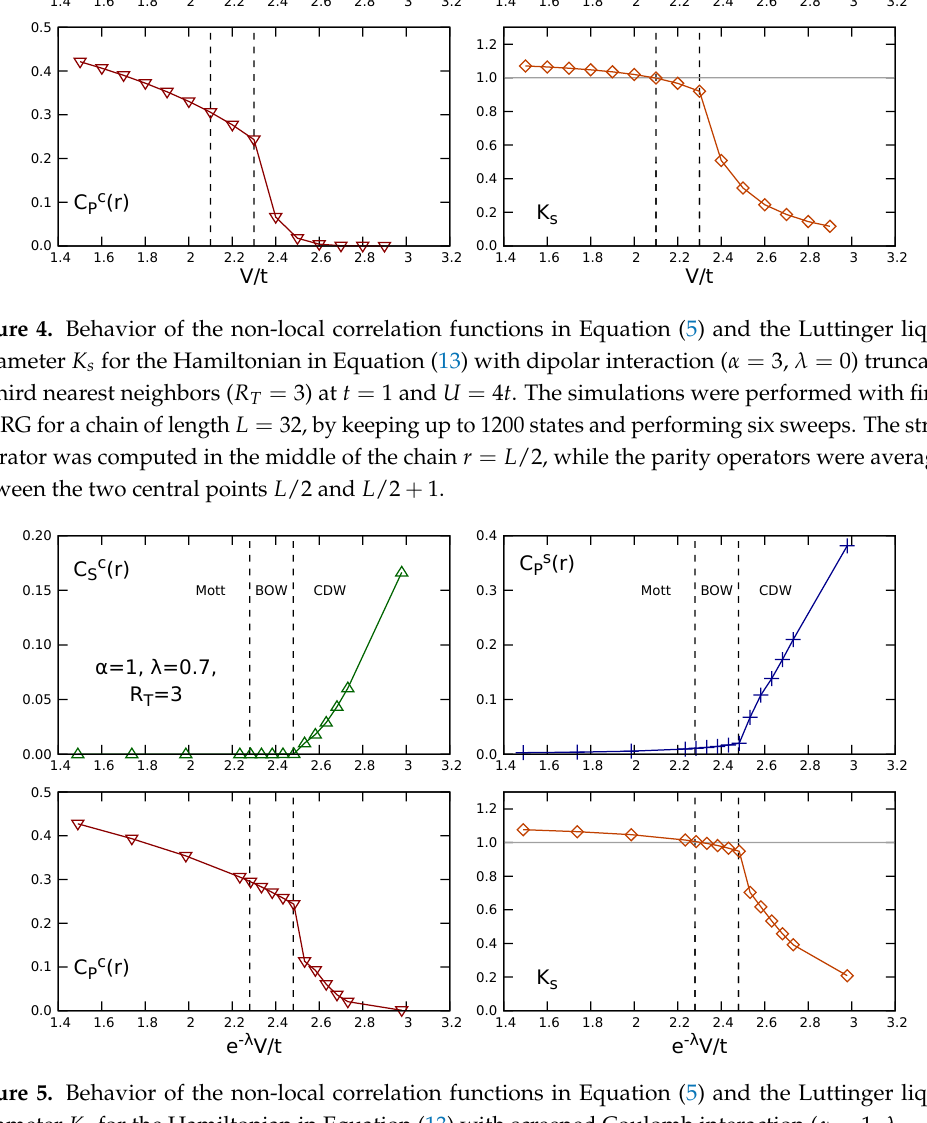
Figure 5. Behavior of the non-local correlation functions in Equation (5) and the Luttinger liquid parameter K s for the Hamiltonian in Equation (13) with screened Coulomb interaction ( α = 1, λ = 0.7) truncated to third nearest neighbors ( R T = 3) at t = 1 and U = 4 t . The simulations were performed with finite DMRG for a chain of length L = 32, by keeping up to 1200 states and performing six sweeps. The string operator was computed in the middle of the chain r = L /2, while the parity operators were averaged between the two central points L /2 and L /2 +